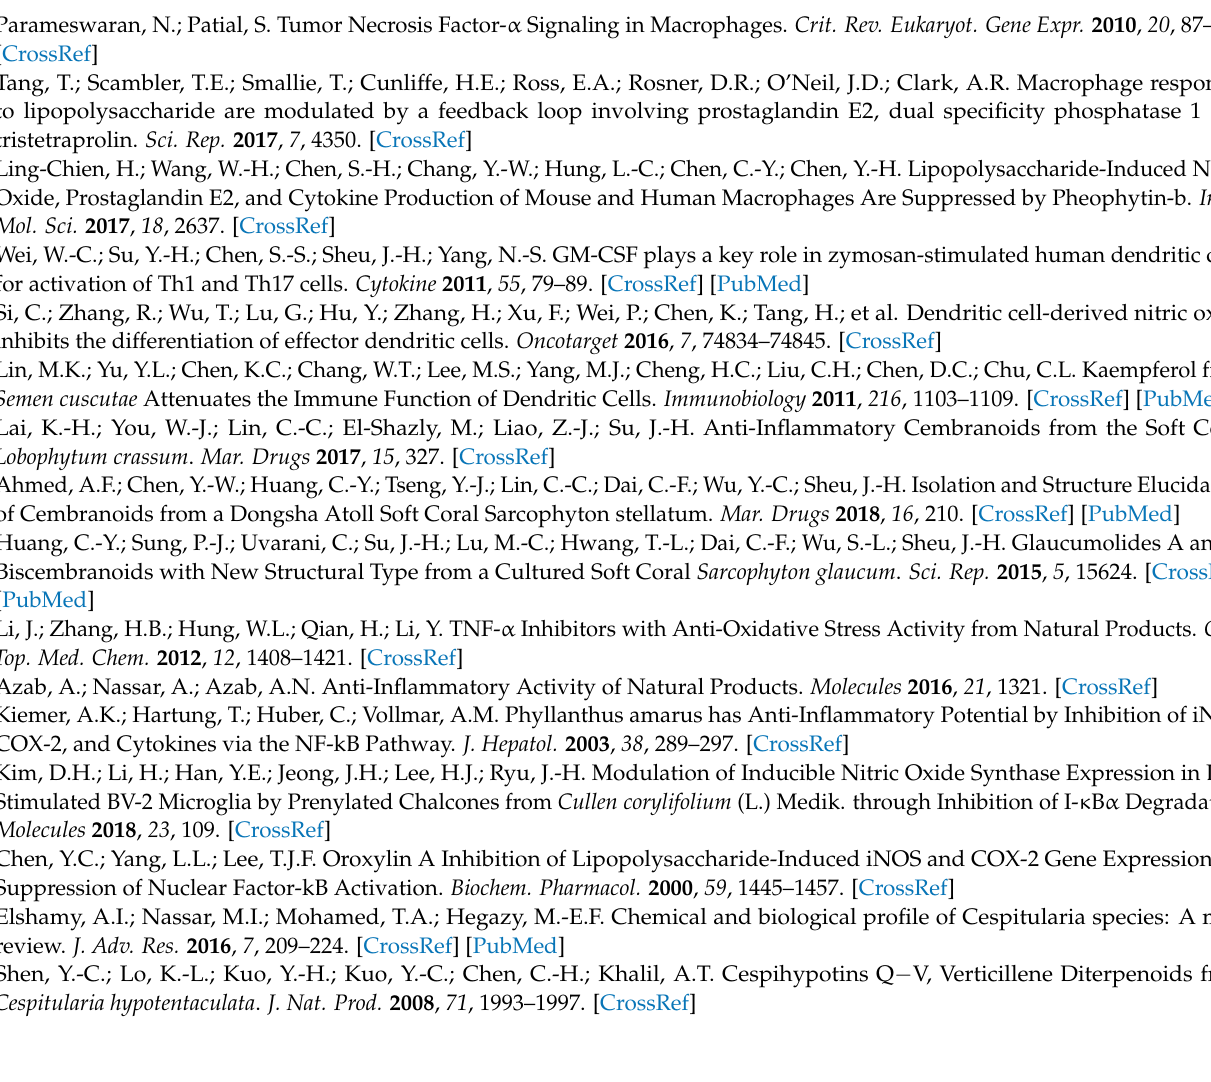
of 16 in CDCl 3 , Figure S111: HMBC spectrum of 16 in CDCl 3 , Figure S112: NOESY spectrum of 16 in CDCl 3 , Figure S113: MMFF lowest energy conformers for 1 , Figure S114: MMFF lowest energy conformers for 2 , Table S1: 1 H and 13 C NMR spectroscopic data of compounds 17 and 18 , Table S2: Energy analysis for MMFF conformational searching of compounds 1 and 2